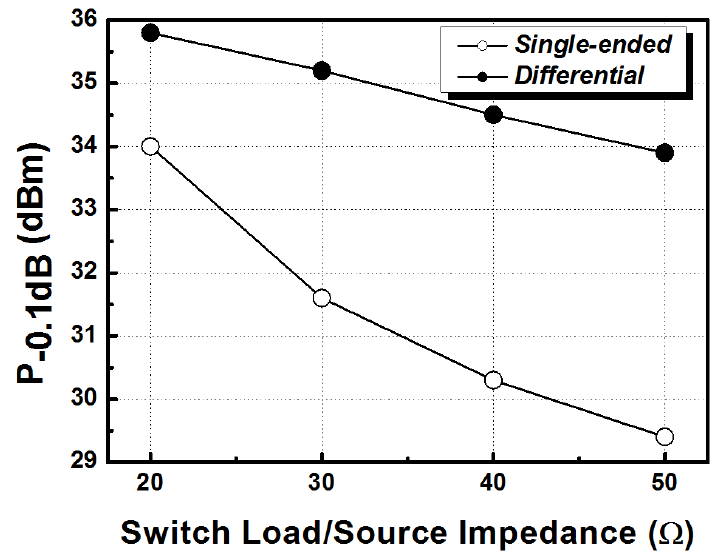
Figure 3. Simulated P − 0.1dB of antenna switches (control voltages are 3 V/2 V and the switches operate at 1.9 GHz).